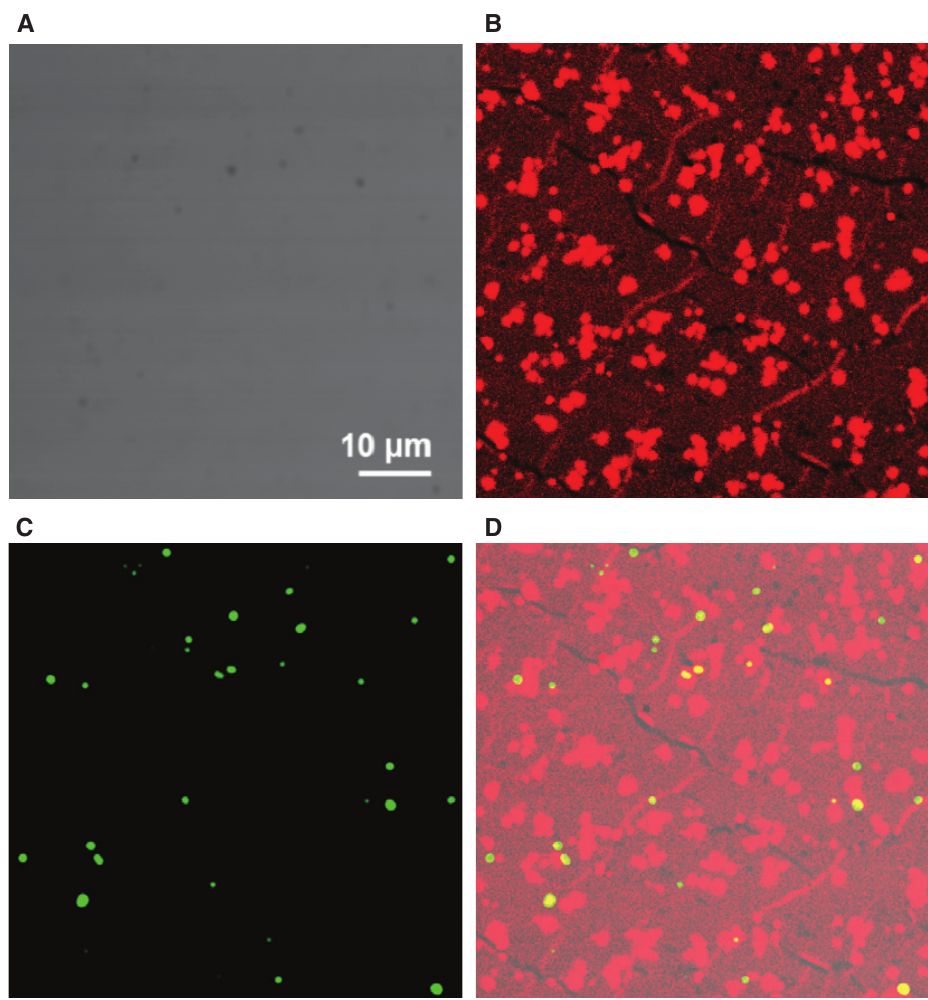
Figure 9: (A) Bright field of monolayer graphene. (B) CARS image of graphene. (C) TPEF + SHG image of graphene. (D) Merged image of bright field + CARS + TPEF + SHG at Raman mode 1360 cm −1